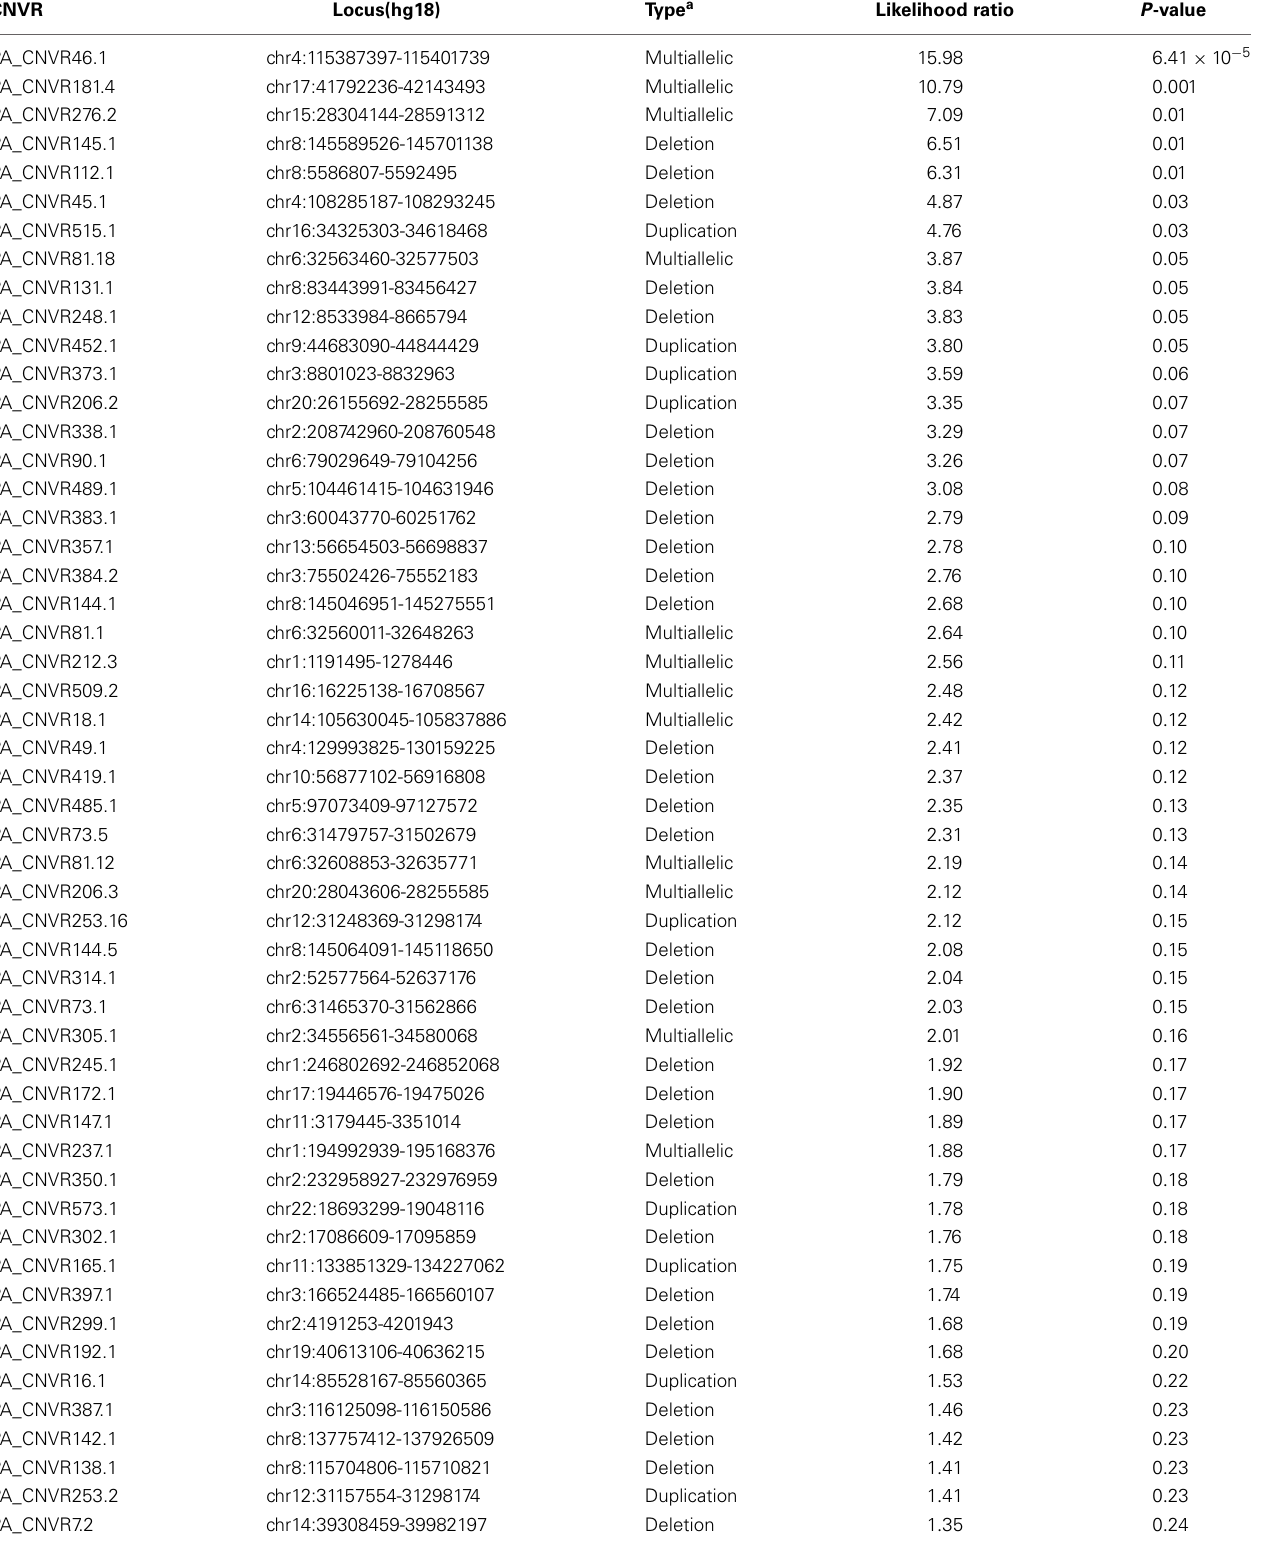
Table 6 | Likelihood ratio tests for the association of 176 CNVR loci with pancreatic cancer